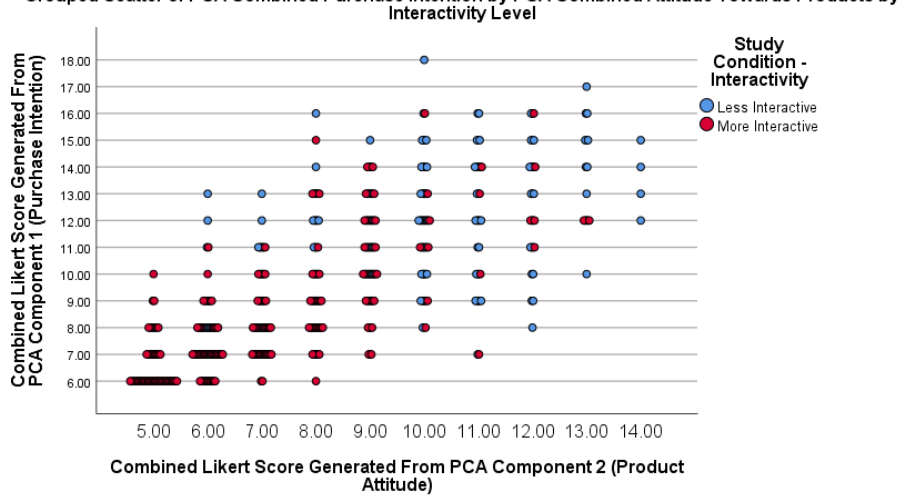
Figure 3. Marginal means of purchase intention—lower- and higher-cost products.